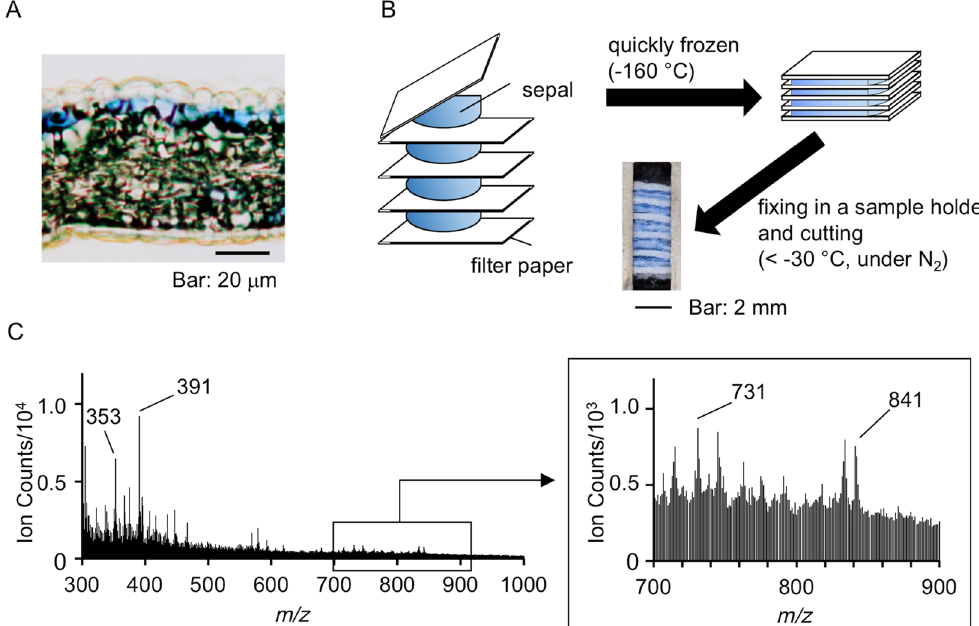
Figure 3. Cryo-TOF-SIMS analysis of the blue sepal tissue. ( A ) Microscopic observation of the transverse section of the blue sepal. ( B ) Preparation of blue sepal sample for cryo-TOF-SIMS. ( C ) Negative cryo-TOF- SIMS spectrum of the transverse surface of the blue sepal